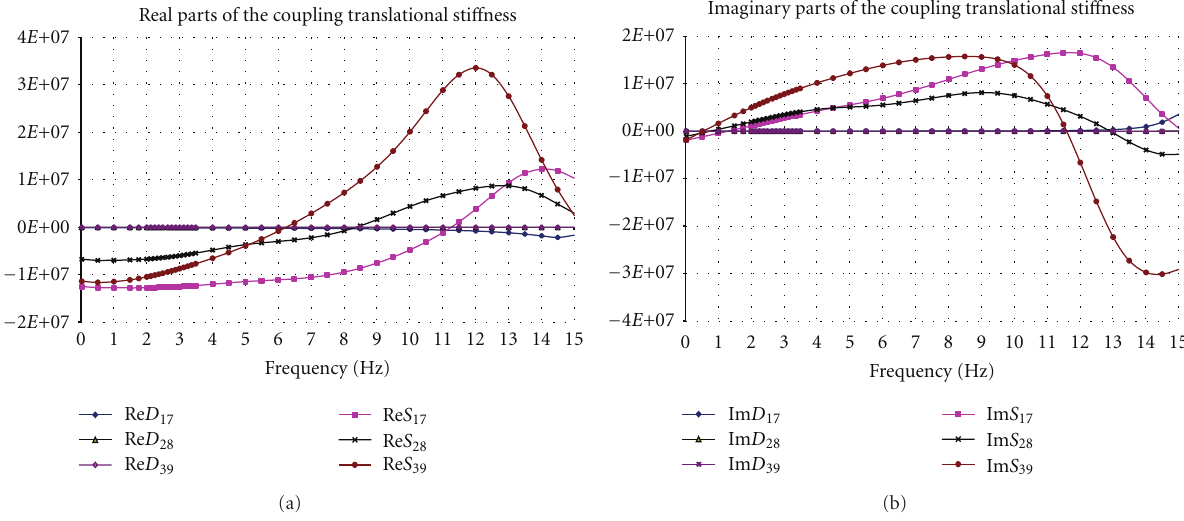
Figure 4: Coupling translational dynamic sti ff ness of the soil and the structure along axes Ox , Oy , Oz . Real parts of the transfer functions alon g Ox